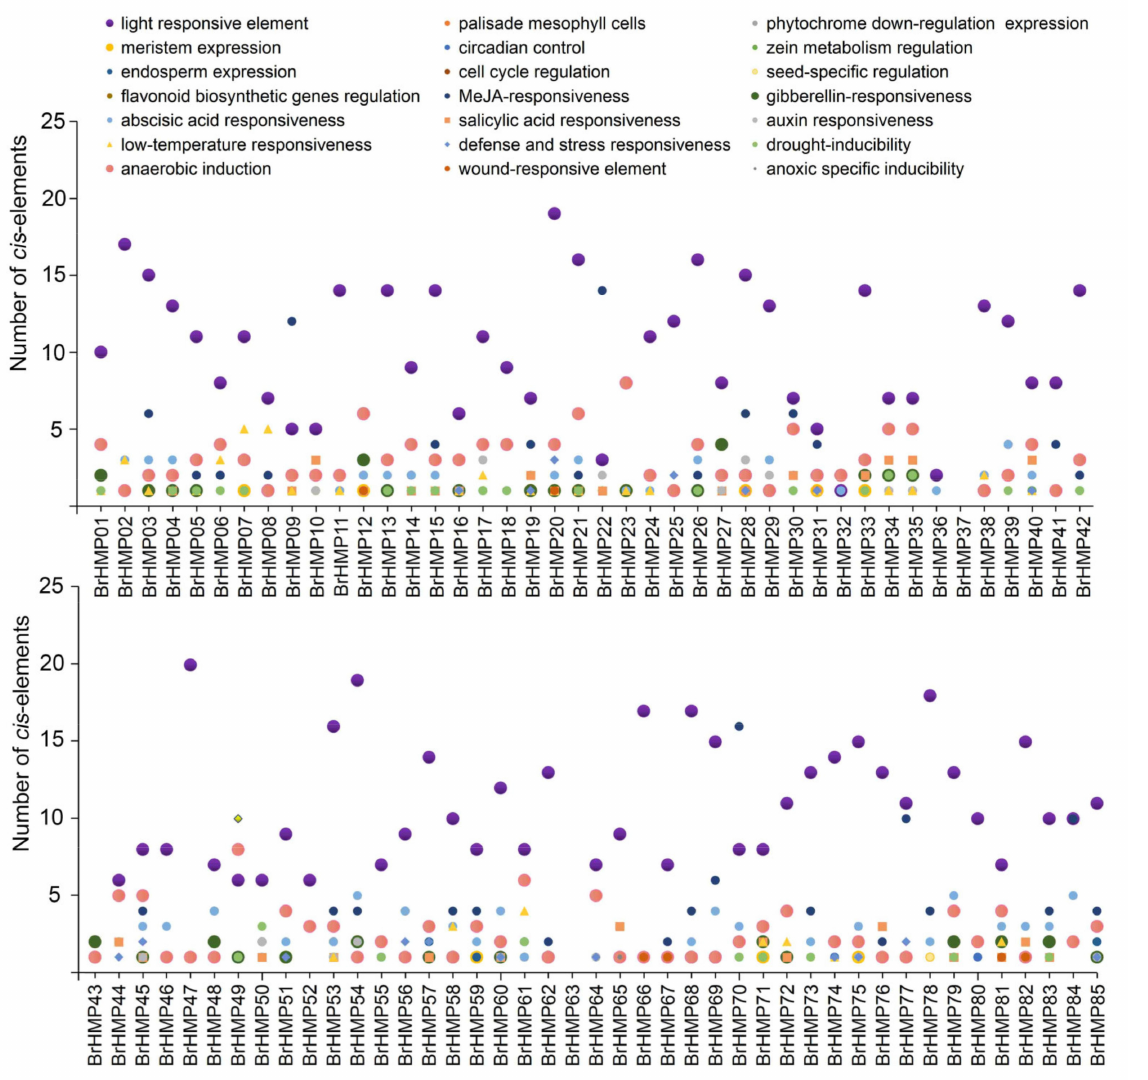
Figure 6. Analysis of cis -elements in promoters of HMP genes in B. rapa